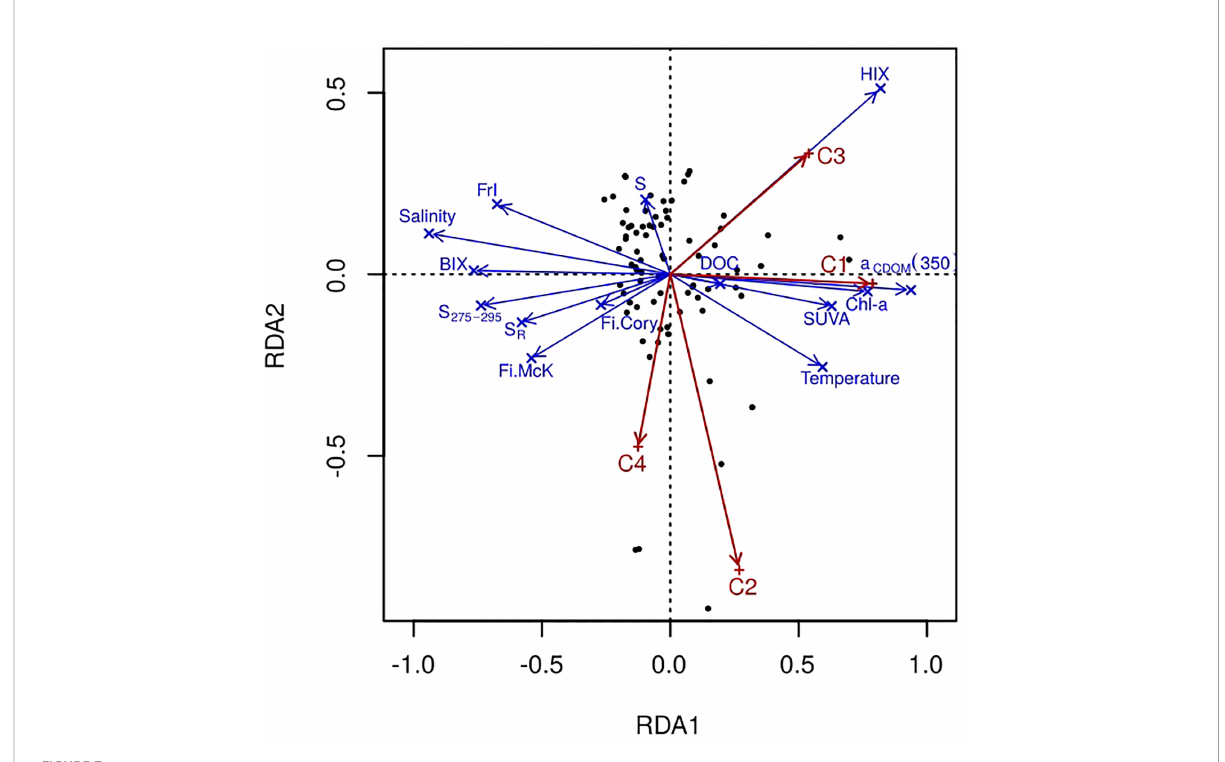
FIGURE 7 Redundancy analysis of spectral parameters and environmental